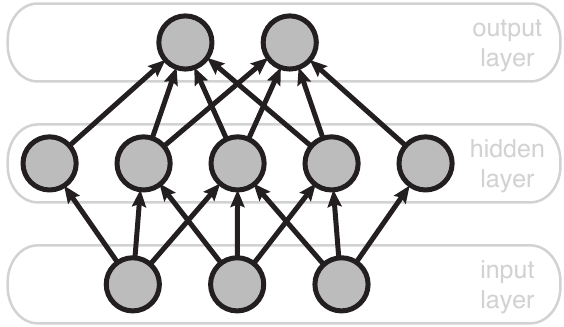
Figure 3: A connectionist network with three input neurons, two output neurons and one hidden layer containing five